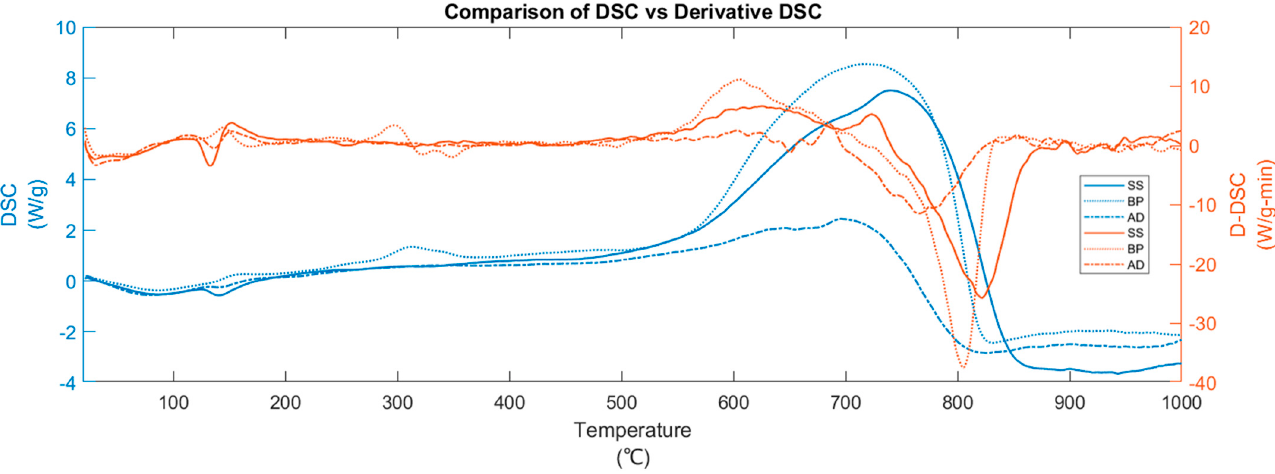
Figure 5. Comparison of DSC and D-DSC curves during pyrolysis of BP, SS, and AD.